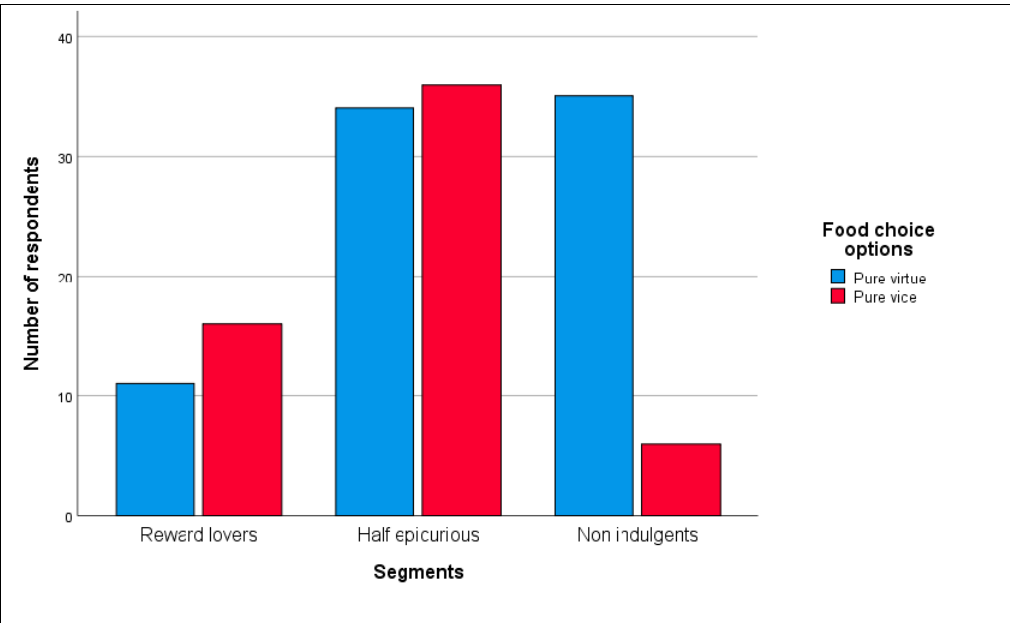
Figure 3. Segments positioning based on food liking and food wanting total scores.